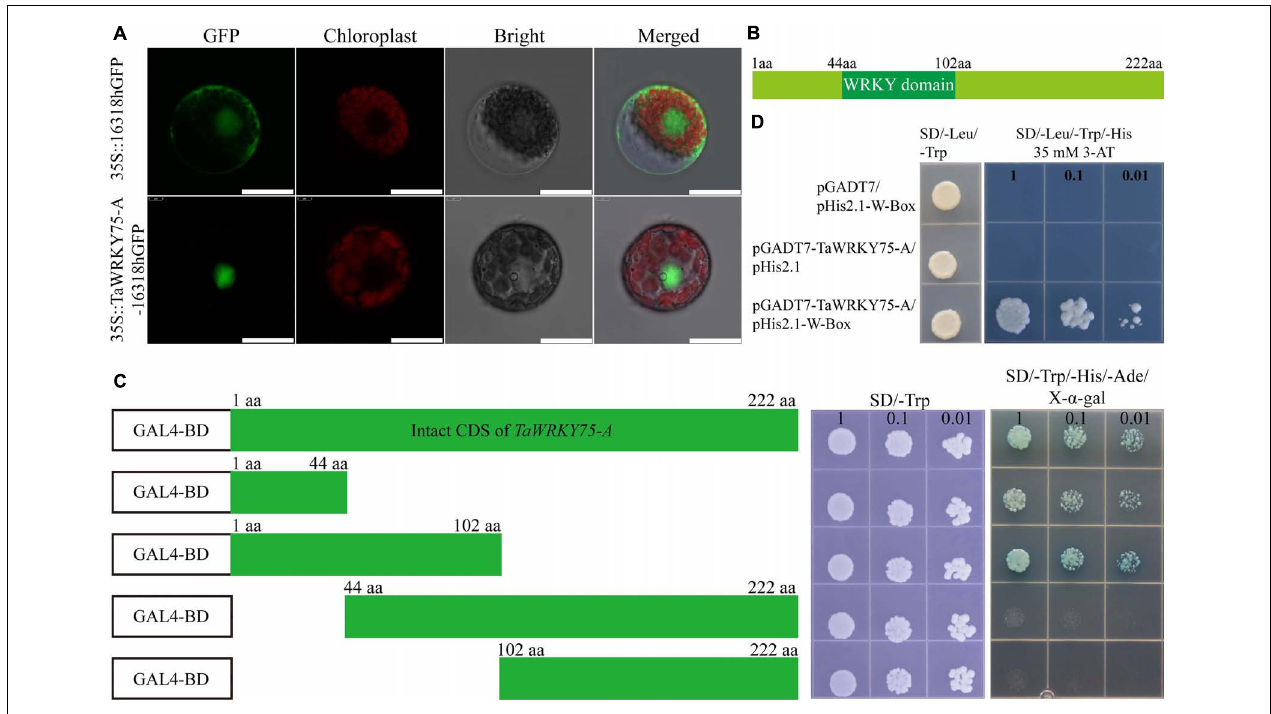
FIGURE 5 | TaWRKY75-A is a typical WRKY transcription factor. (A) The subcellular location of TaWRKY75-A . Scale bars: 20 µ m. (B) The protein structure of TaWRKY75-A. (C) Transactivation activity test of TaWRKY75-A in the yeast GAL4 system. CDS, coding sequence. (D) TaWRKY75-A can bind to the W-box motif. Yeast-one-hybrid assay was